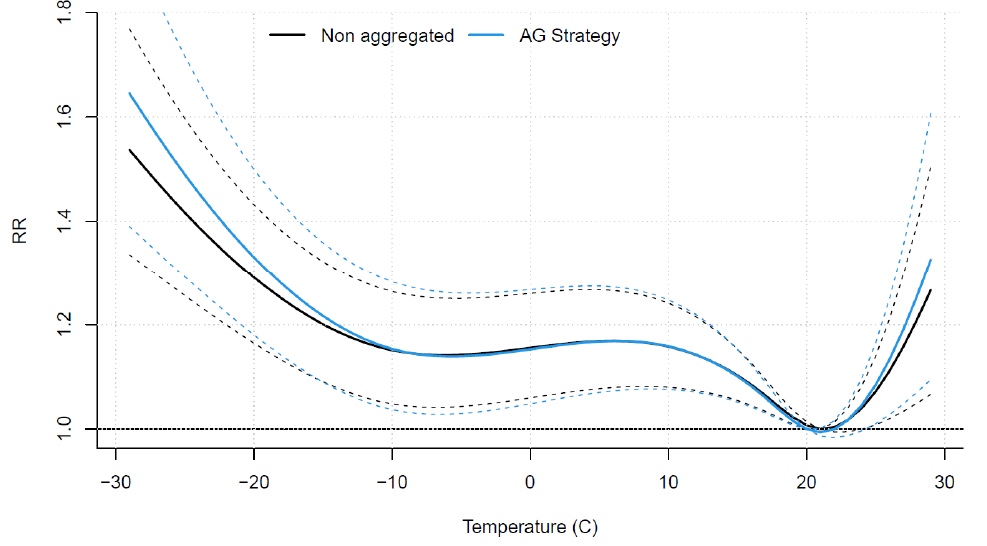
Figure 1. Estimated overall cumulative relative risk (RR) of temperature for the classical model and the first strategy (AG strategy). Dashed lines represent 95% confidence intervals.